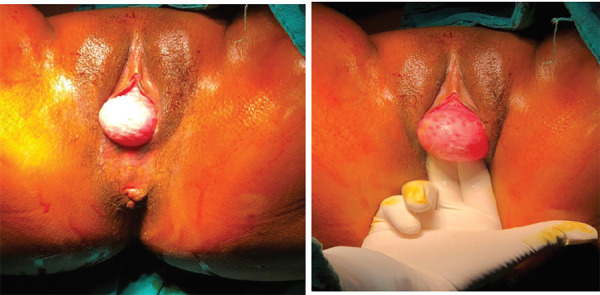
Gartner duct cysts.